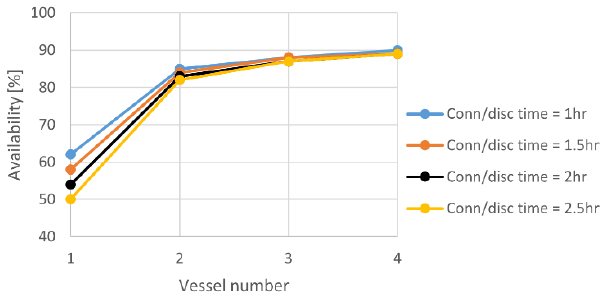
Fig. 21. Farm availability versus vessel number for various connection/disconnection times, in the case of assembly team=3 and onshore